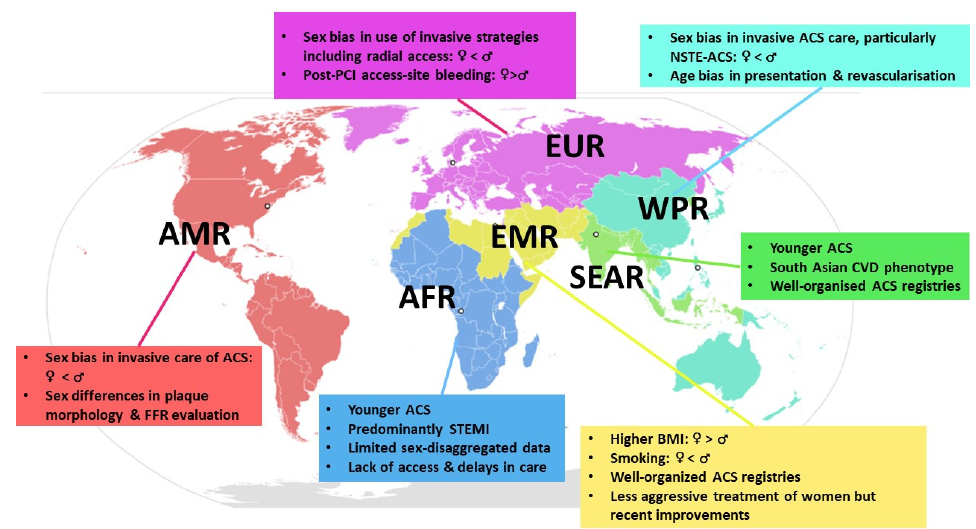
Figure 1. Sex disparities in acute coronary syndromes globally: Significant characteristics in each WHO region. World Health Organization (WHO) regions; African Region (AFR); South-East Asian Region (SEAR); European Region (EUR); Eastern Mediterranean Region (EMR); Western Pacific Region (WPR). Acute coronary syndrome (ACS); Body Mass Index (BMI); Cardiovascular disease (CVD); Fractional Flow Reserve (FFR): Non-ST segment elevation acute coronary syndrome (NSTE-ACS); Percutaneous Coronary Intervention (PCI); ST-Segment elevation myocardial infarction (STEMI).